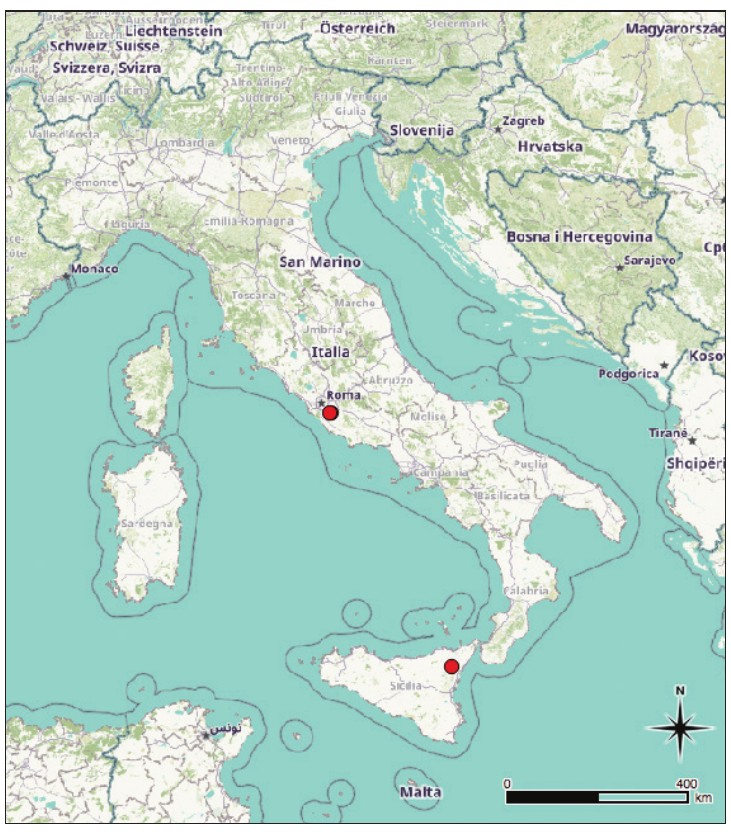
Figure 8. Distribution map of Vicia incisa in Italy.